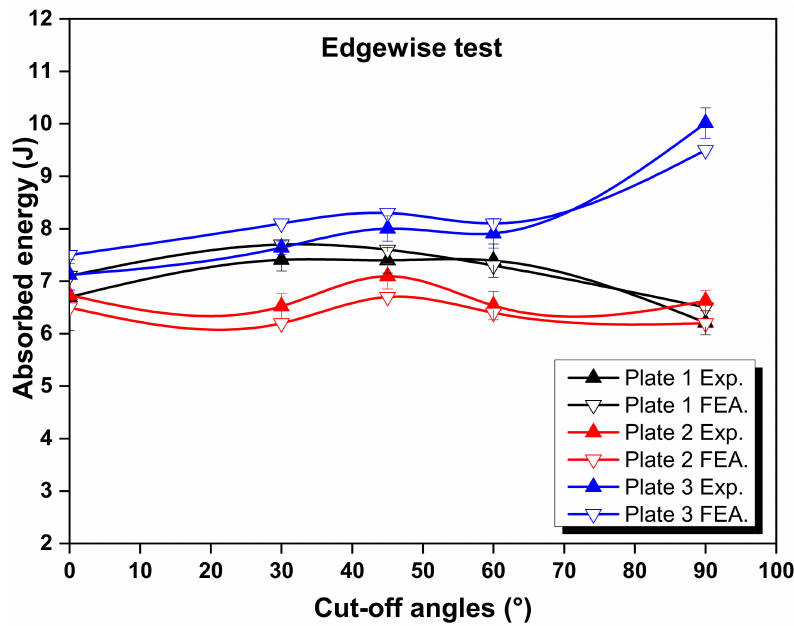
Figure 4. Absorbed energy at various cut-off angles for the edgewise test vs. finite element